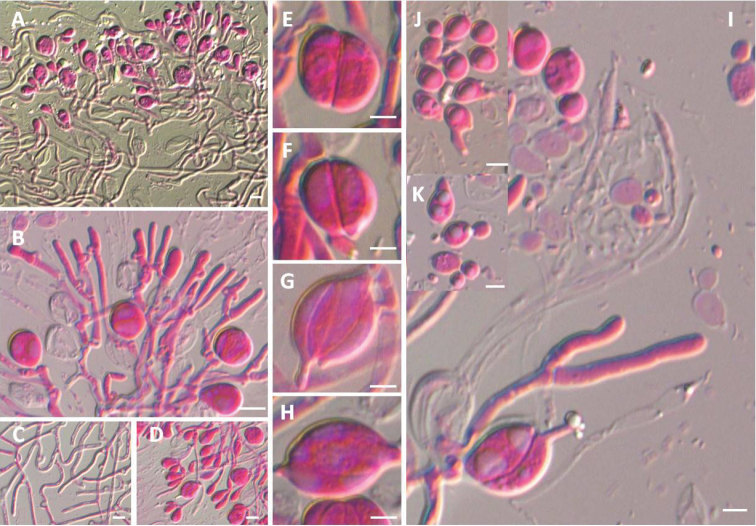
Microscopic structure of Tremellacheejenii (HMAS 279589). A Section through hymenium B Hyphidia from context C Hyphae from context D Probasidia E–H Mature basidia I Mature basidia and conidia produced from the sterigmata J–K Basidiospres and its germination with short sterigma. Scale bars: 10 μm (A–D), 5 μm (E–J).